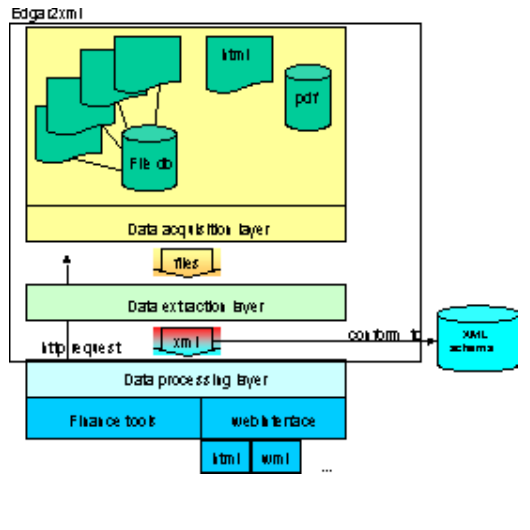
Figure 3 Overview of Edgar2xml's